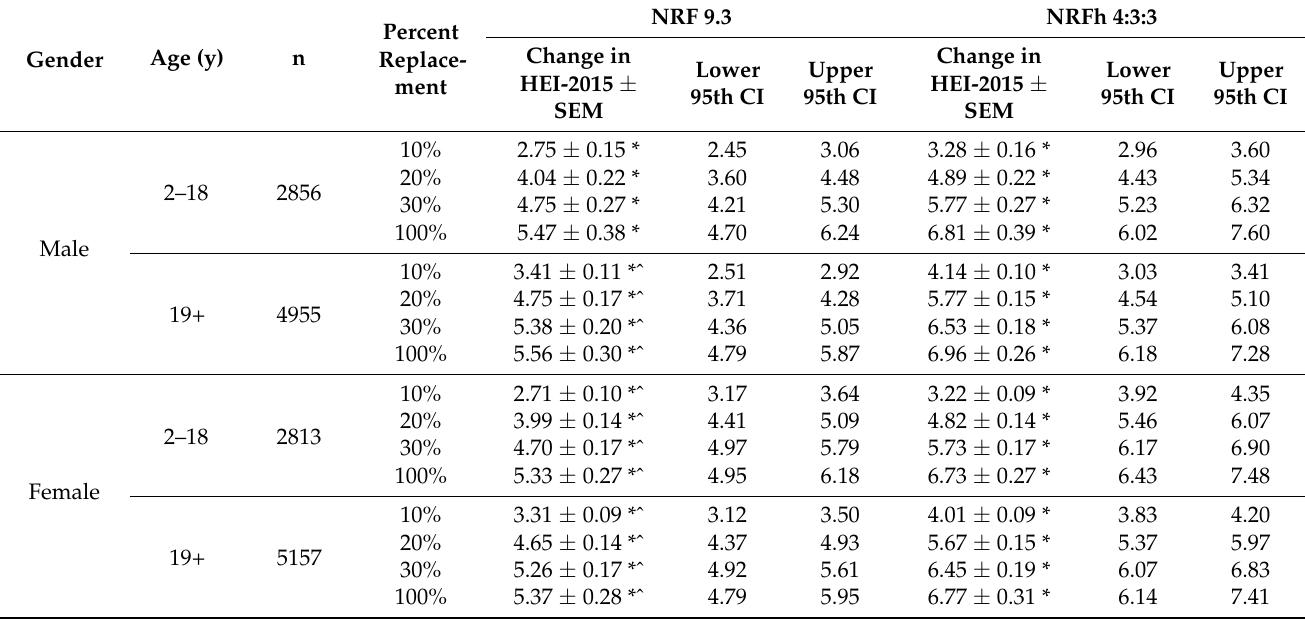
Table 5. Effect of replacing nutrient density T1 foods with T3 foods at 10%, 20%, 30%, and 100% level on HEI-2015 scores by gender and age group.